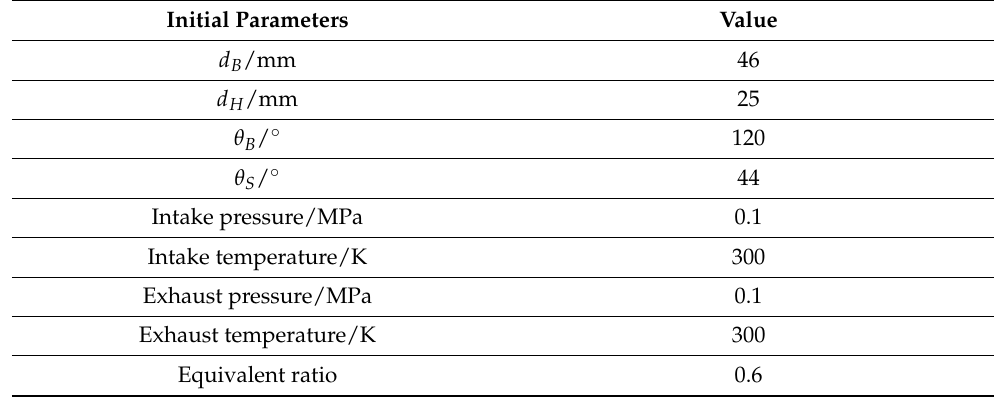
Figure 1. Schematic diagram and work principle of MFPSE; ( a ) schematic diagram; ( b ) work principle. Table 1. Parameters of MFPSE.